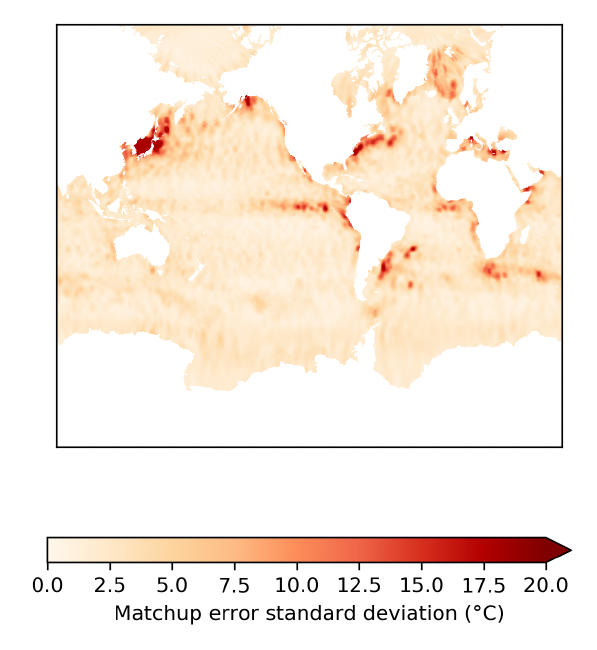
Figure 6. Error standard deviations specified for the matchups between the reference dataset and the sensors to be bias corrected.